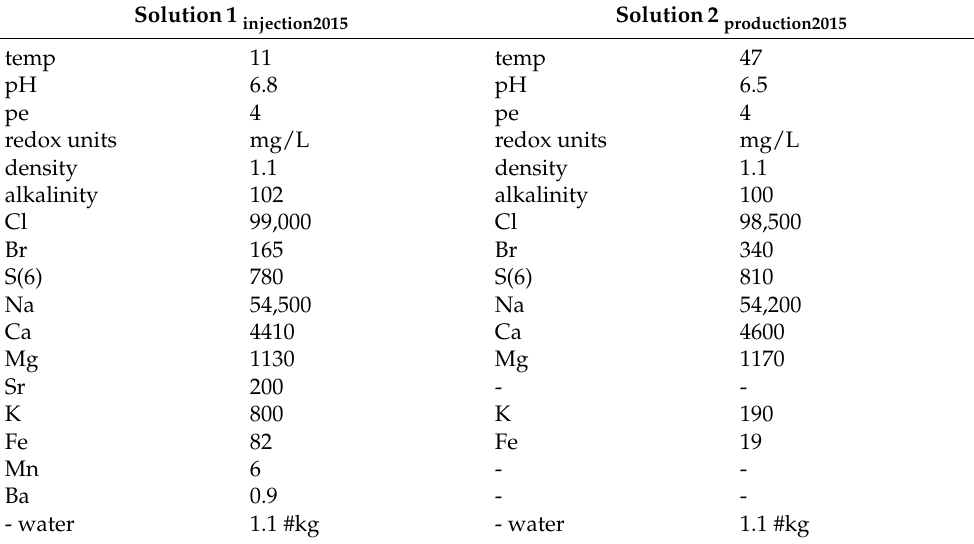
Table 5. Example of PHREEQC input data for running the speciation simulations.